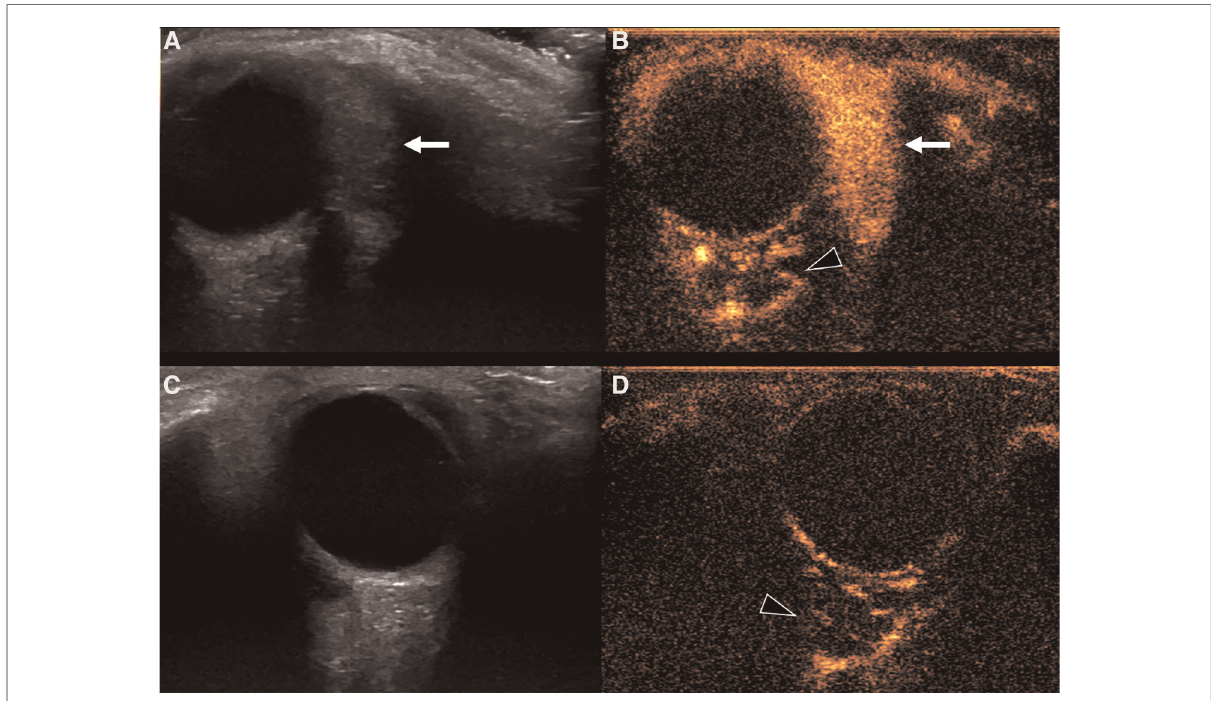
FIGURE 3 Us and CEUS of a left orbital infantile hemangioma (IH) in a 3-year-old girl: the patient was initially referred for a forehead red macule on the left and a slight ipsilateral orbital proptosis. ( A,B ) Depict US of the left orbit, while US of the right orbit is represented in ( C,D ). At B mode US ( A ) a uniformly hyperechoic mass was discovered (white arrow) with rapid and complete enhancement at CEUS ( B , white arrow) Of note, left retrobulbar vessels appeared more prominent than the contralateral side (arrowhead in B and D , respectively). The orbital mass showed the same US characteristics of the IH of the forehead (not